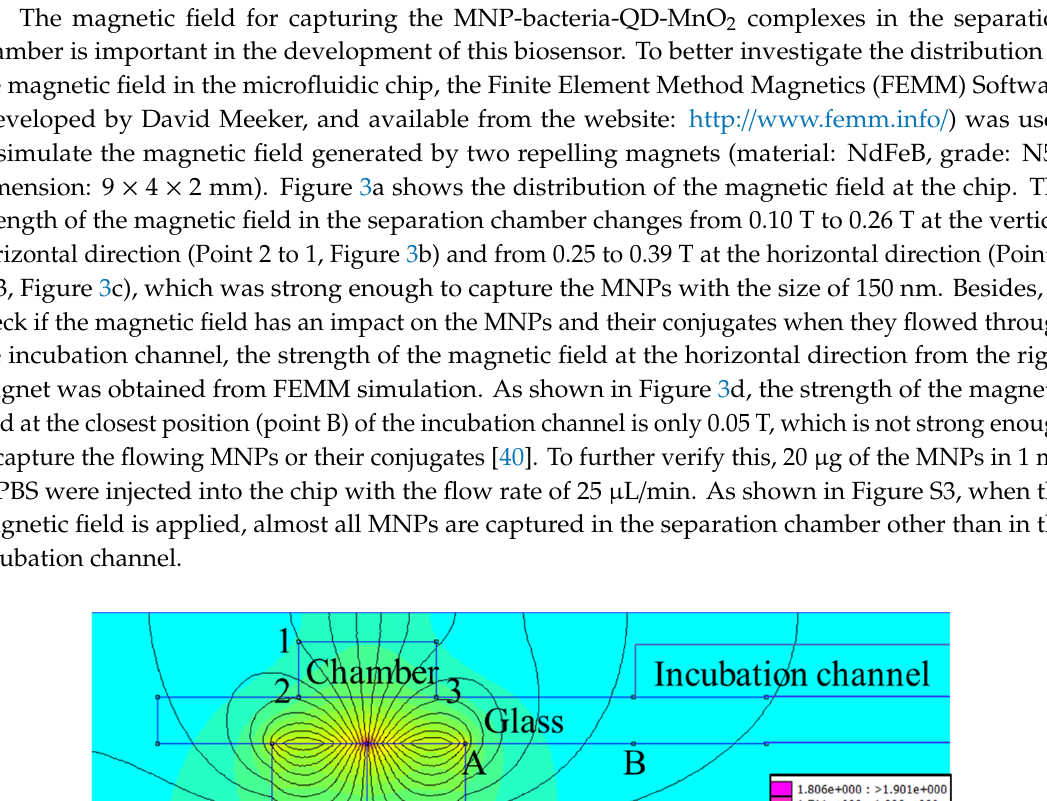
7 of 15 Figure 2. ( a ) The TEM image of the MnO 2 NFs; ( b ) The TEM image of the MnO 2 -QD NFs. The inset